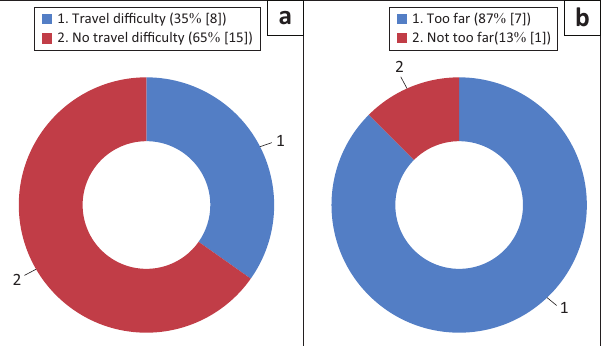
FIGURE 4: Percentage (and number) of non-attending patients who believed whether each factor contributed to their non-attendance: (a) travel was too difficult, n = 23; (b) travel difficulty – relation to distance, n = 8. Only those who had travel difficulty were asked if it was because of the distance required to be